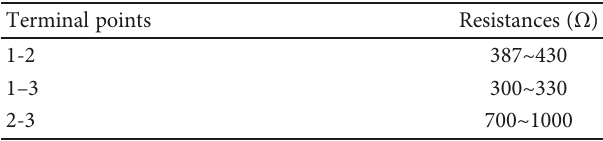
Figure 5: (a) Complete three-layer device. (b) Three terminals labeled for further data measurement. (c) 3D view of the printed layers to check uniformity (scanning was taken along the direction of − Y to +Y). Table 4: Measured resistance before etching.